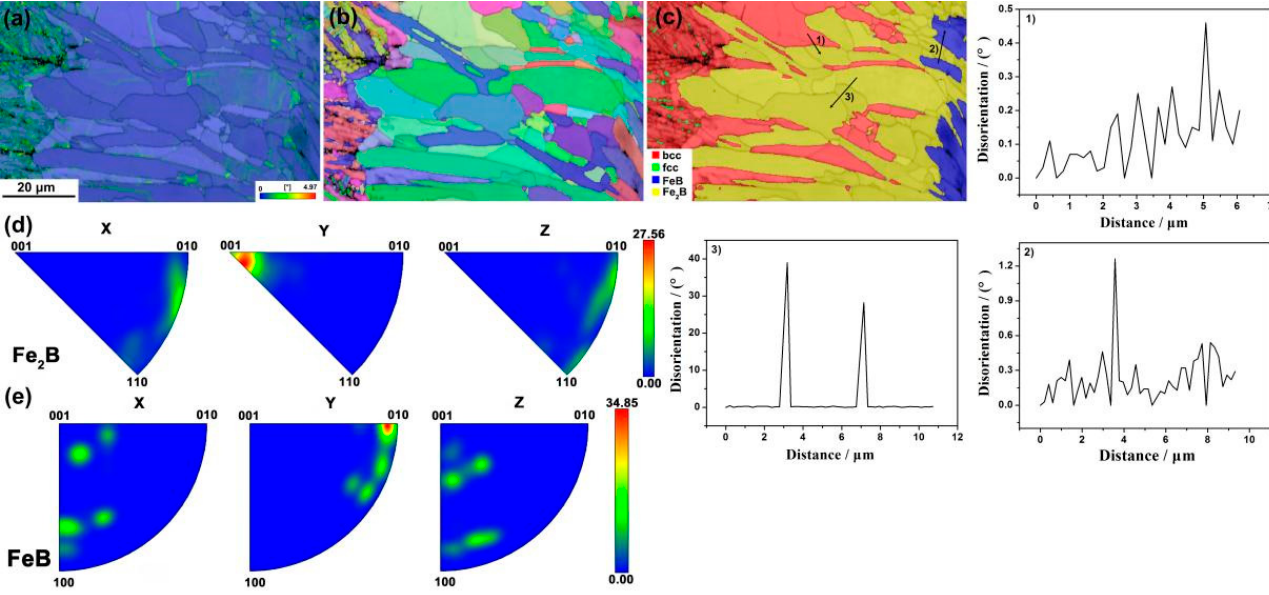
Figure 6. EBSD images of borided coating of sample BA-8: ( a ) KAM map; ( b ) IPF map; ( c ) phase map; ( d ) IPF of Fe 2 B; ( e ) IPF of FeB.